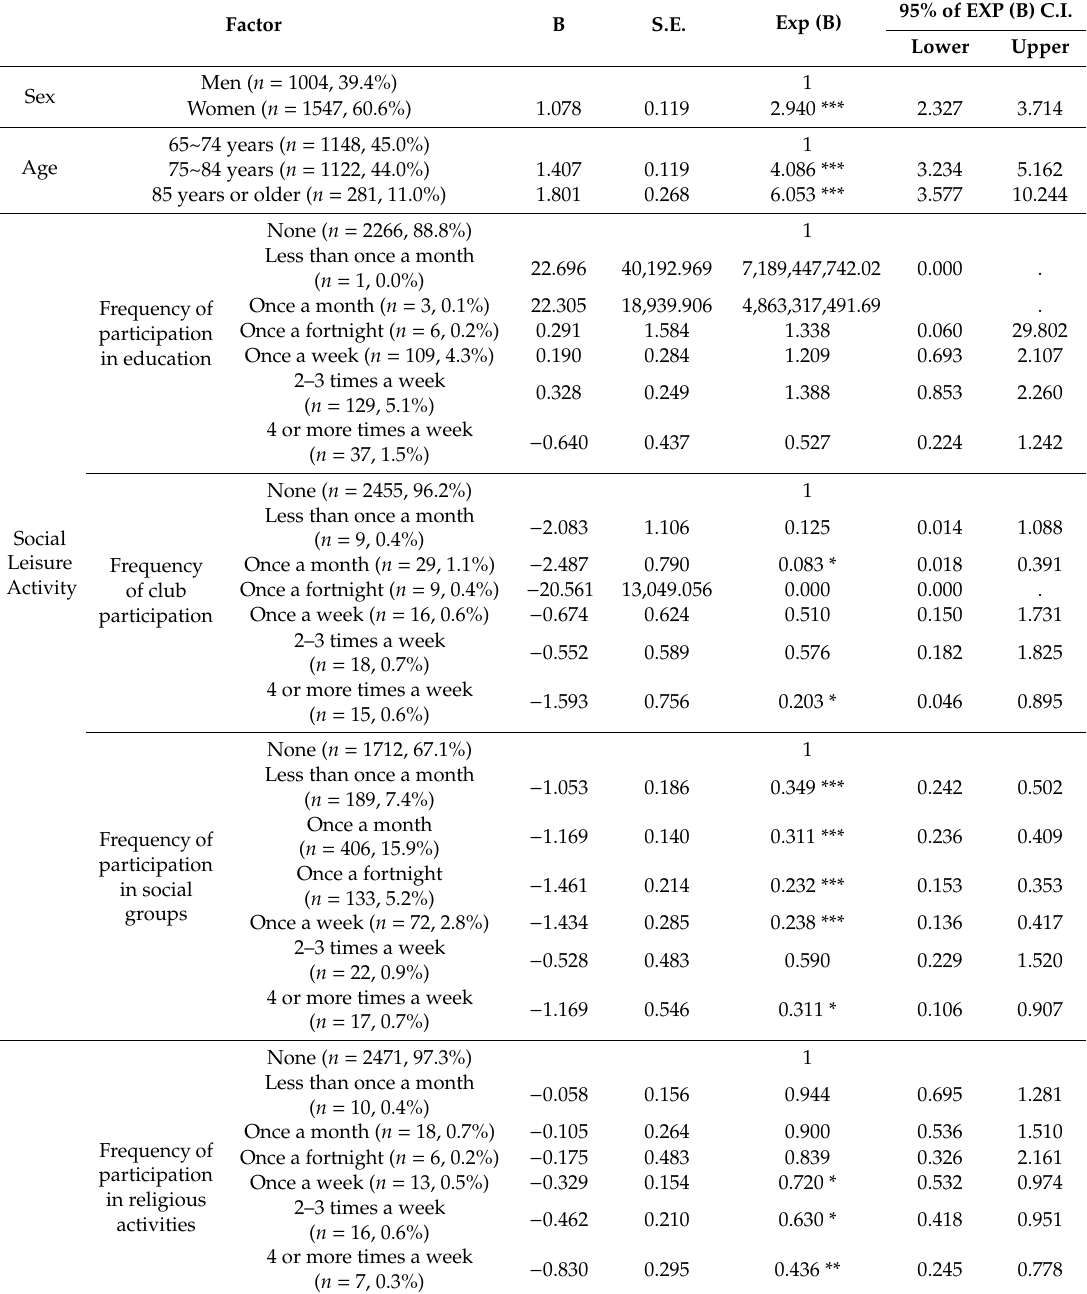
Table 4. Logistic regression analysis according to health and frailty